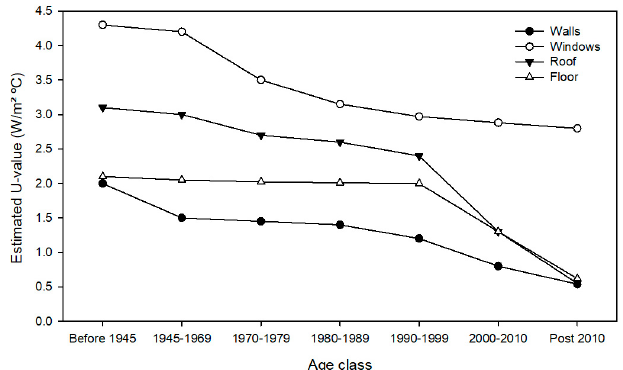
Figure 2. Estimated U-Value for building envelop elements of Portuguese building stock considering construction age class (data source [32]).